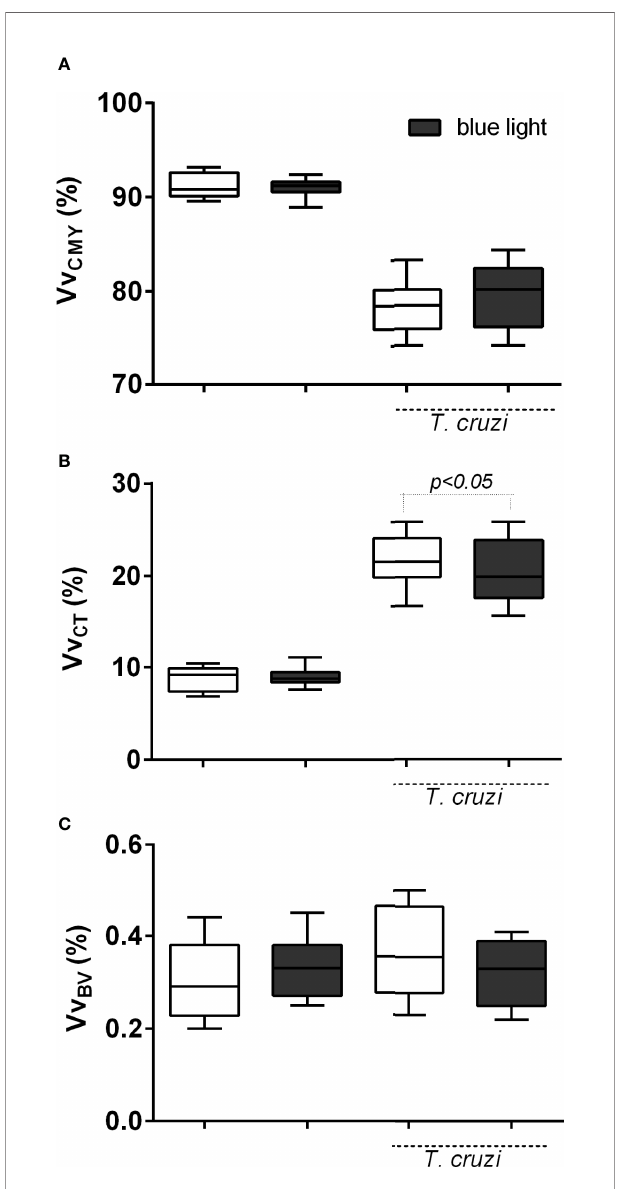
FIGURE 5 | Cardiac microstructural reorganization according to stereological principles. (A) Volume density (Vv, %) of the heart stroma [connective tissue (CT)], (B) parenchyma [cardiomyocytes [CMY)], and (C) blood vessels (BV). p<0.05 means differences between groups under conventional and blue light